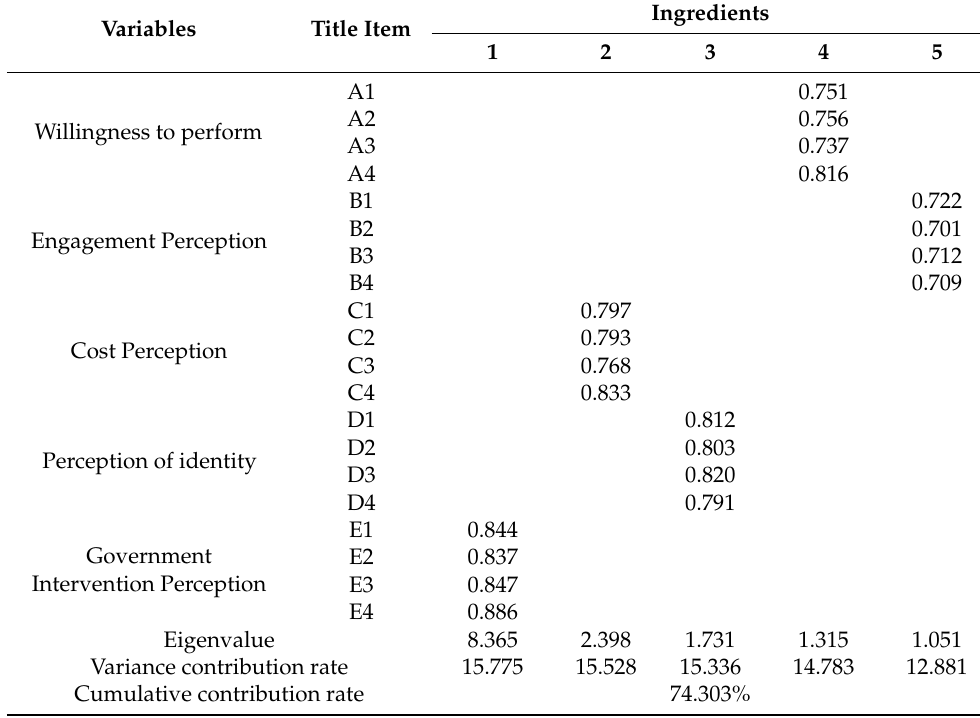
Table 6. Factor rotation